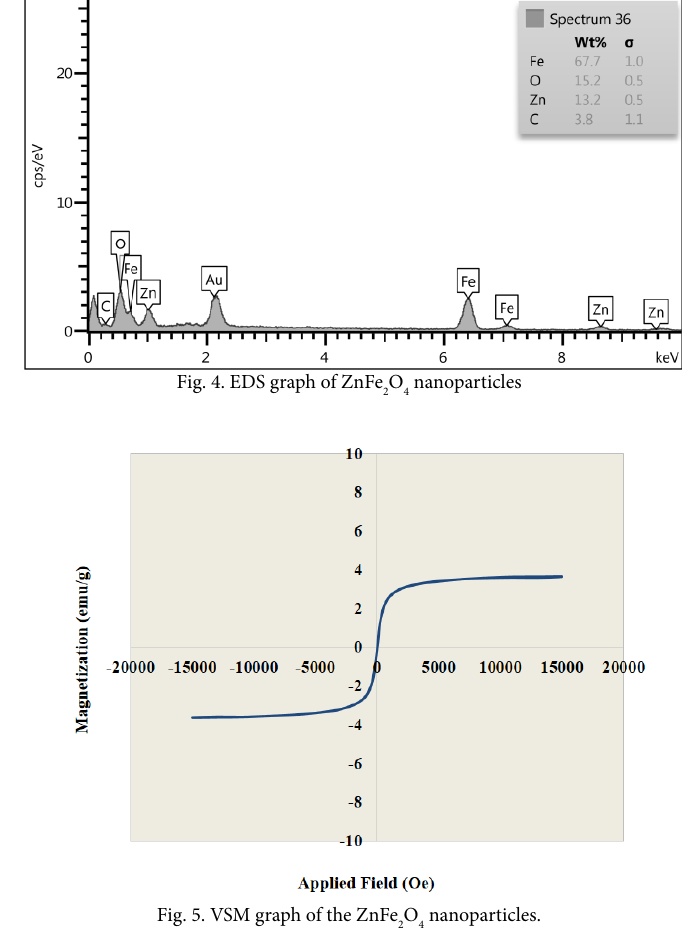
Fig. 5. VSM graph of the ZnFe Figure 5 : VSM graph of the ZnFe 2 O 4 nanoparticles.